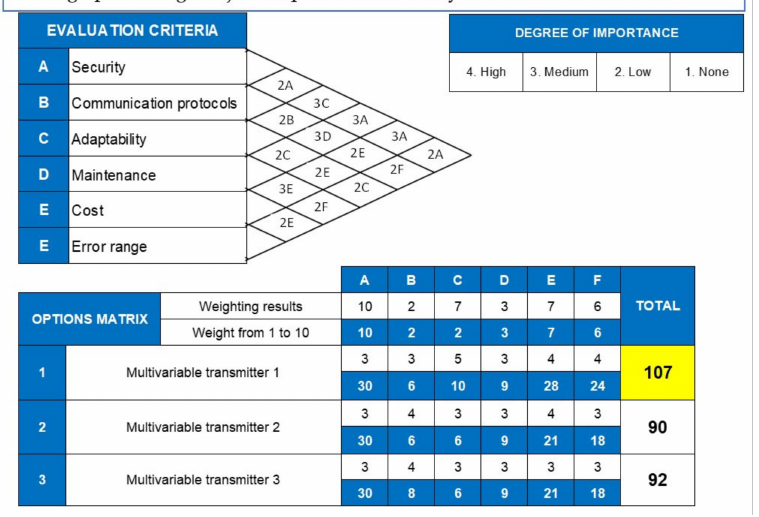
Figure 3. Evaluation matrix for the transmitters. Yellow Highlight: This is to highlight the highest score achieved in the technical